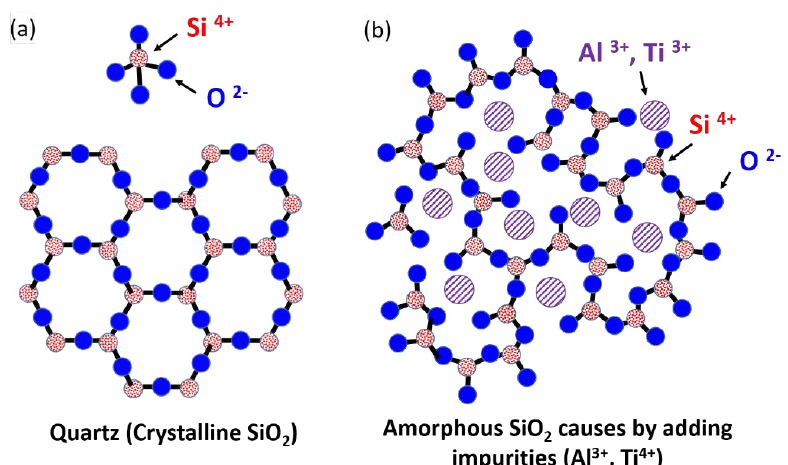
Figure 10. Schematic of ( a ) crystalline SiO 2 and ( b ) amorphous SiO 2 induced by adding impurities (Al 3+ and Ti 4+ ).